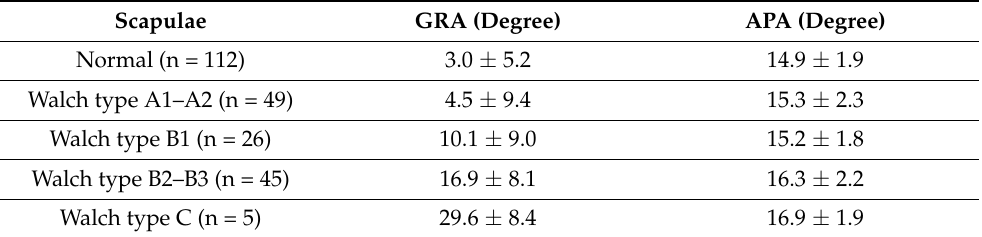
Table 2. Glenoid retroversion angle (GRA; mean ± SD) and acromion posterior angle (APA; mean ± SD) for normal and osteoarthritic scapulae, subclassified according to the updated Walch classification. Scapulae